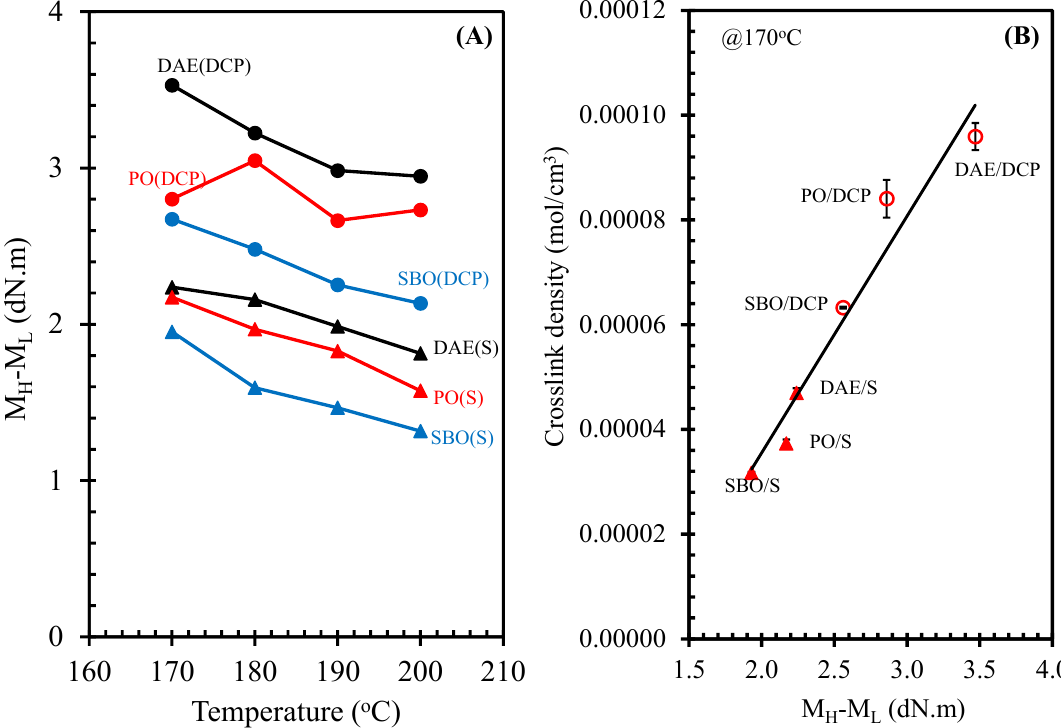
Figure 9. Torque difference (M H -M L ) as a function of curing temperatures ( A ) and the correlation between the crosslink density and the torque difference at a curing temperature of 170 °C ( B ) of NR compounds containing different types of oils under various curing systems.